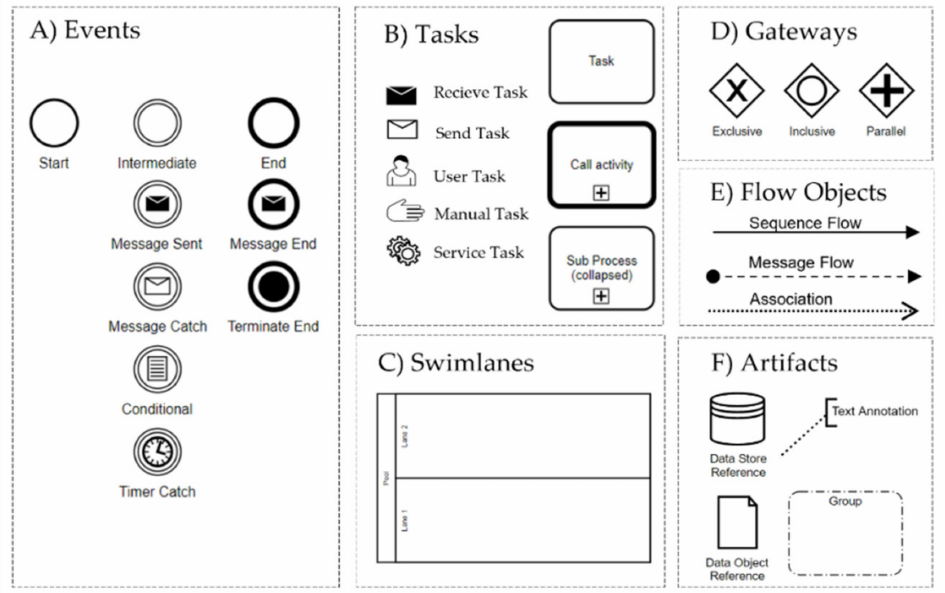
Figure 1. Used BPMN elements in this work: ( A ) events, ( B ) tasks, ( C ) swimlanes, ( D ) gateways, ( E ) flow objects, and ( F )